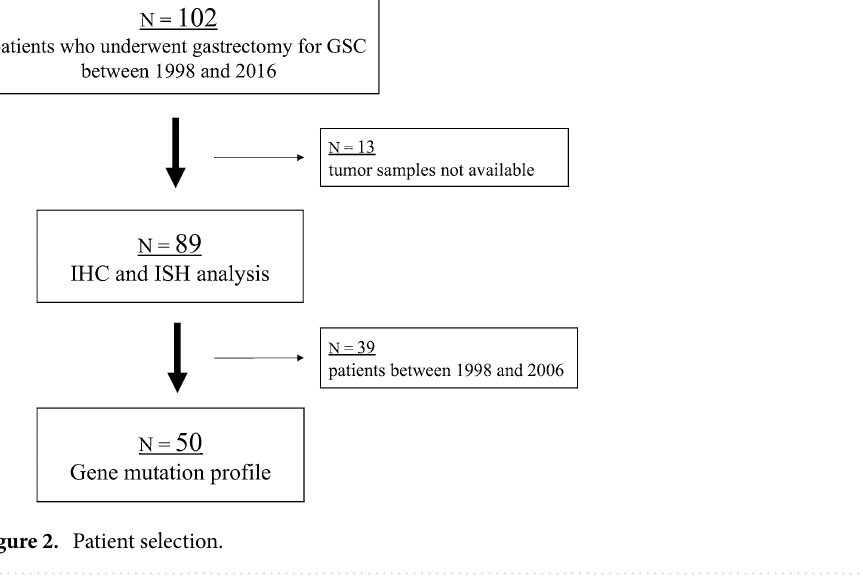
Figure 2. Patient